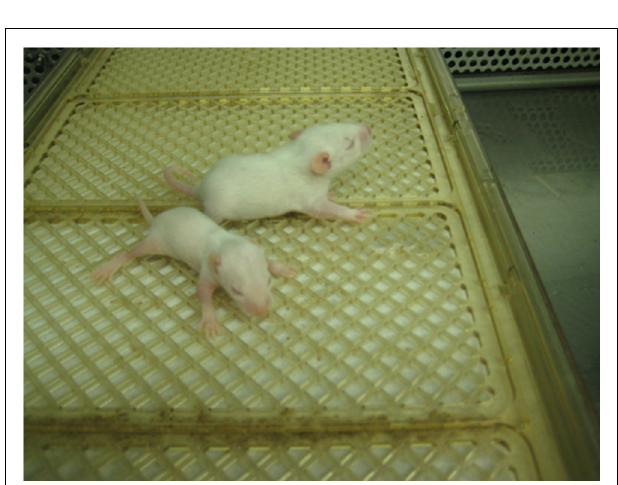
FIGURE 3 | Hypothetical model of renal iron handling. Filtered Tf–Fe is reabsorbed in proximal tubule cells by receptor-mediated endocytosis. Potential receptors include cubilin–megalin complex, a possible novel Tf receptor (TfR), and TfR1. Reabsorption of iron bound to a chelator (LCN2) has also been described, although the receptor involved is less clear. Alternatively, ferrous iron is directly imported into the cell by DMT1.